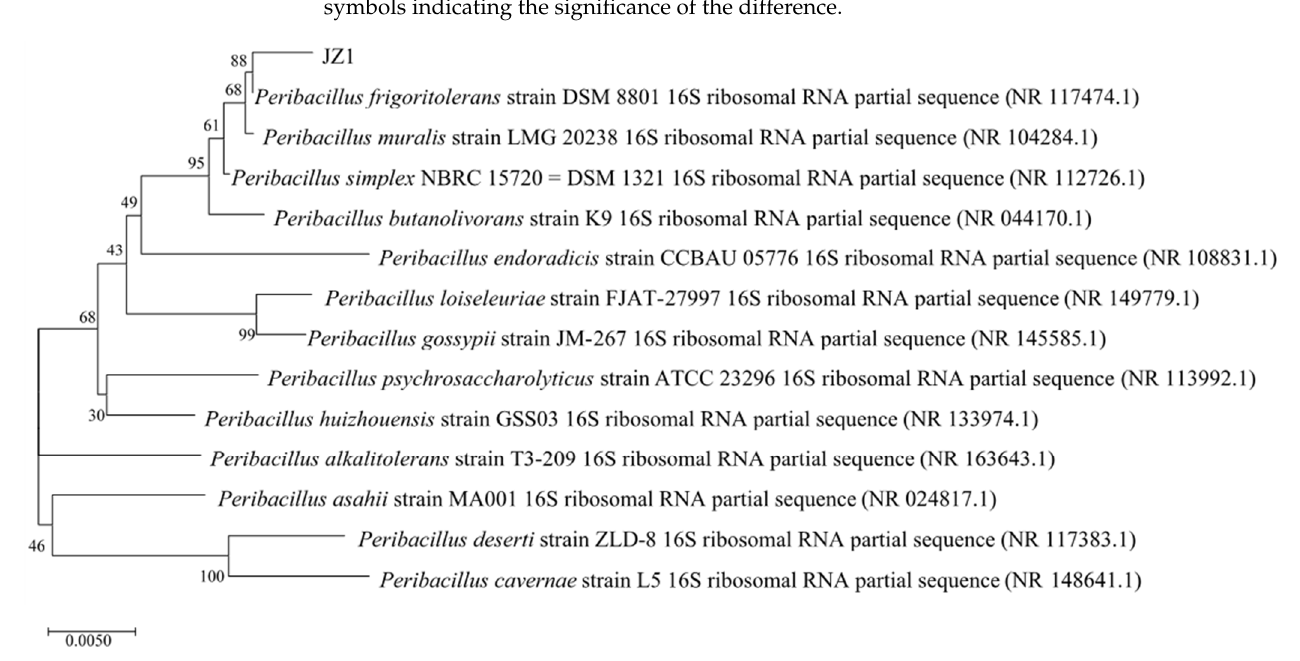
Figure 1. Degradation rate of PBAT film by strains in basic salt + 1% tryptone medium; a–e are symbols indicating the significance of the difference.